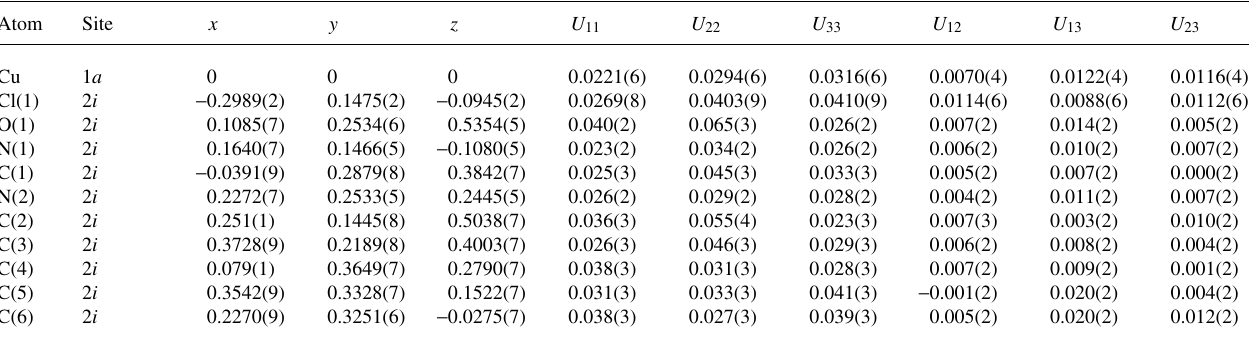
Table 3. Atomic coordinates and displacement parameters (in Å 2 )